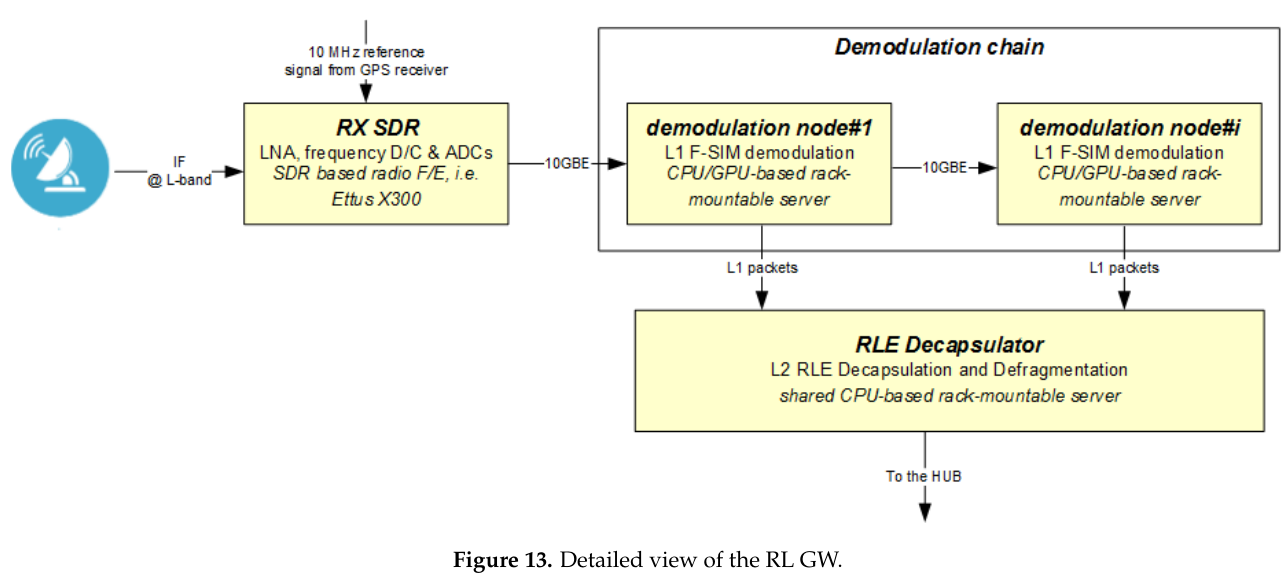
Figure 13. Detailed view of the RL GW.